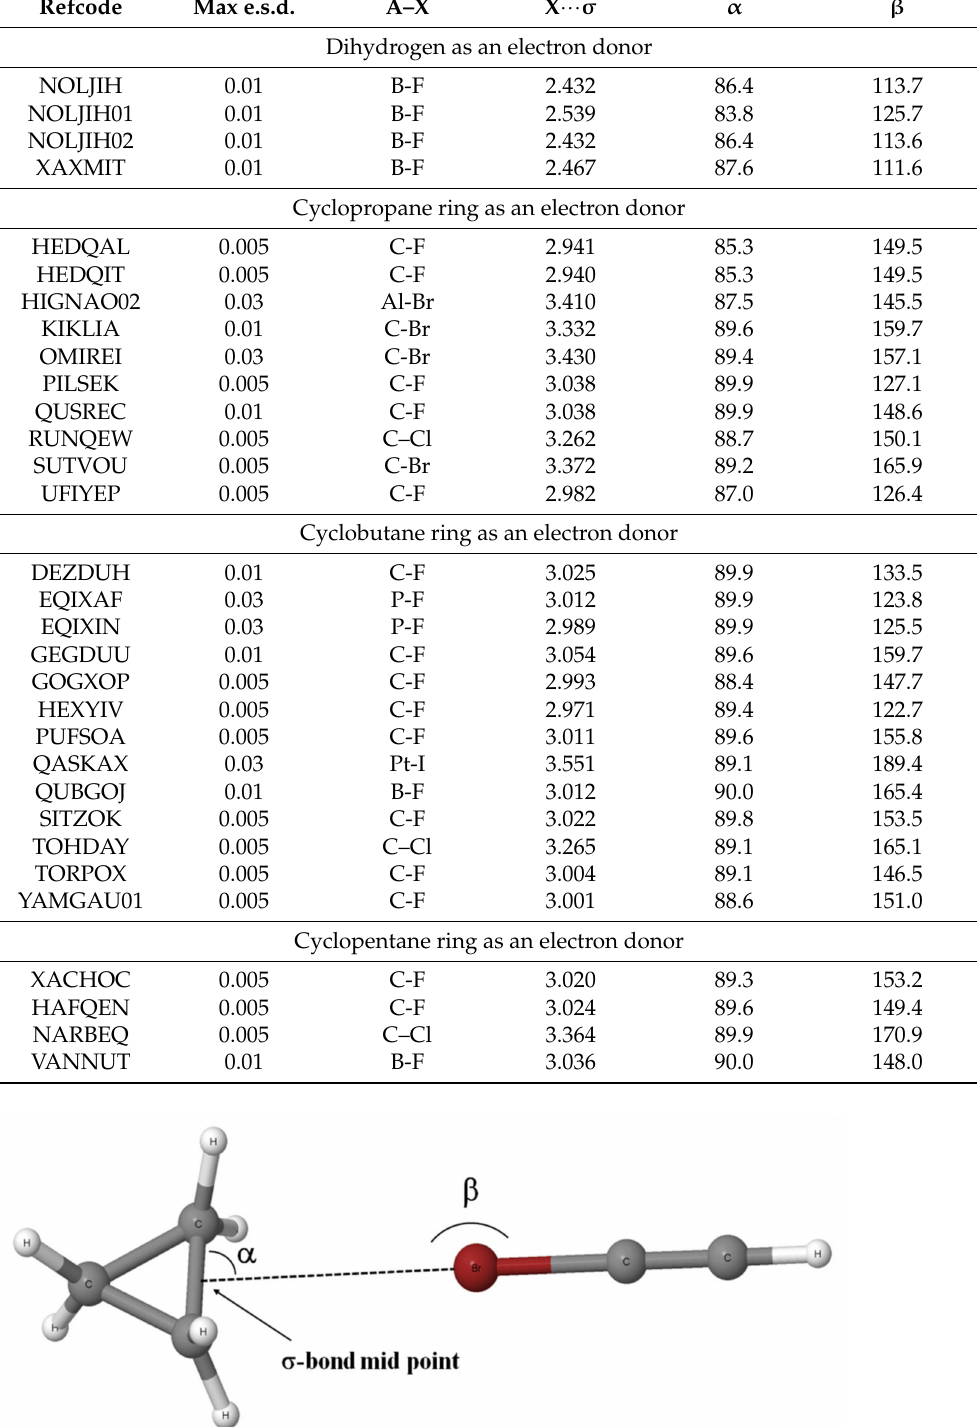
Table 1. The crystal structures that contain A–X ··· σ halogen bonds: refcodes, e.s.ds values (Å), types of A–X bonds, X ··· σ distances (Å), and α and β angles (in degrees, see Scheme 3) are given.